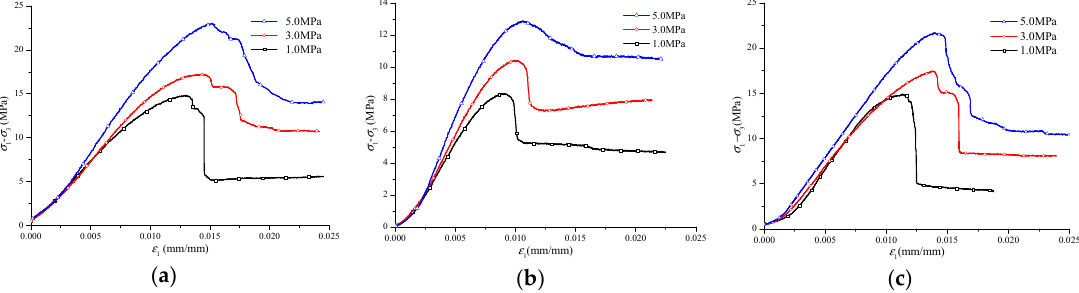
Figure 5. Stress-strain behavior of rock samples under different confining pressures. ( a ) Mudstone, ( b ) sandstone, ( c ) sandy mudstone.